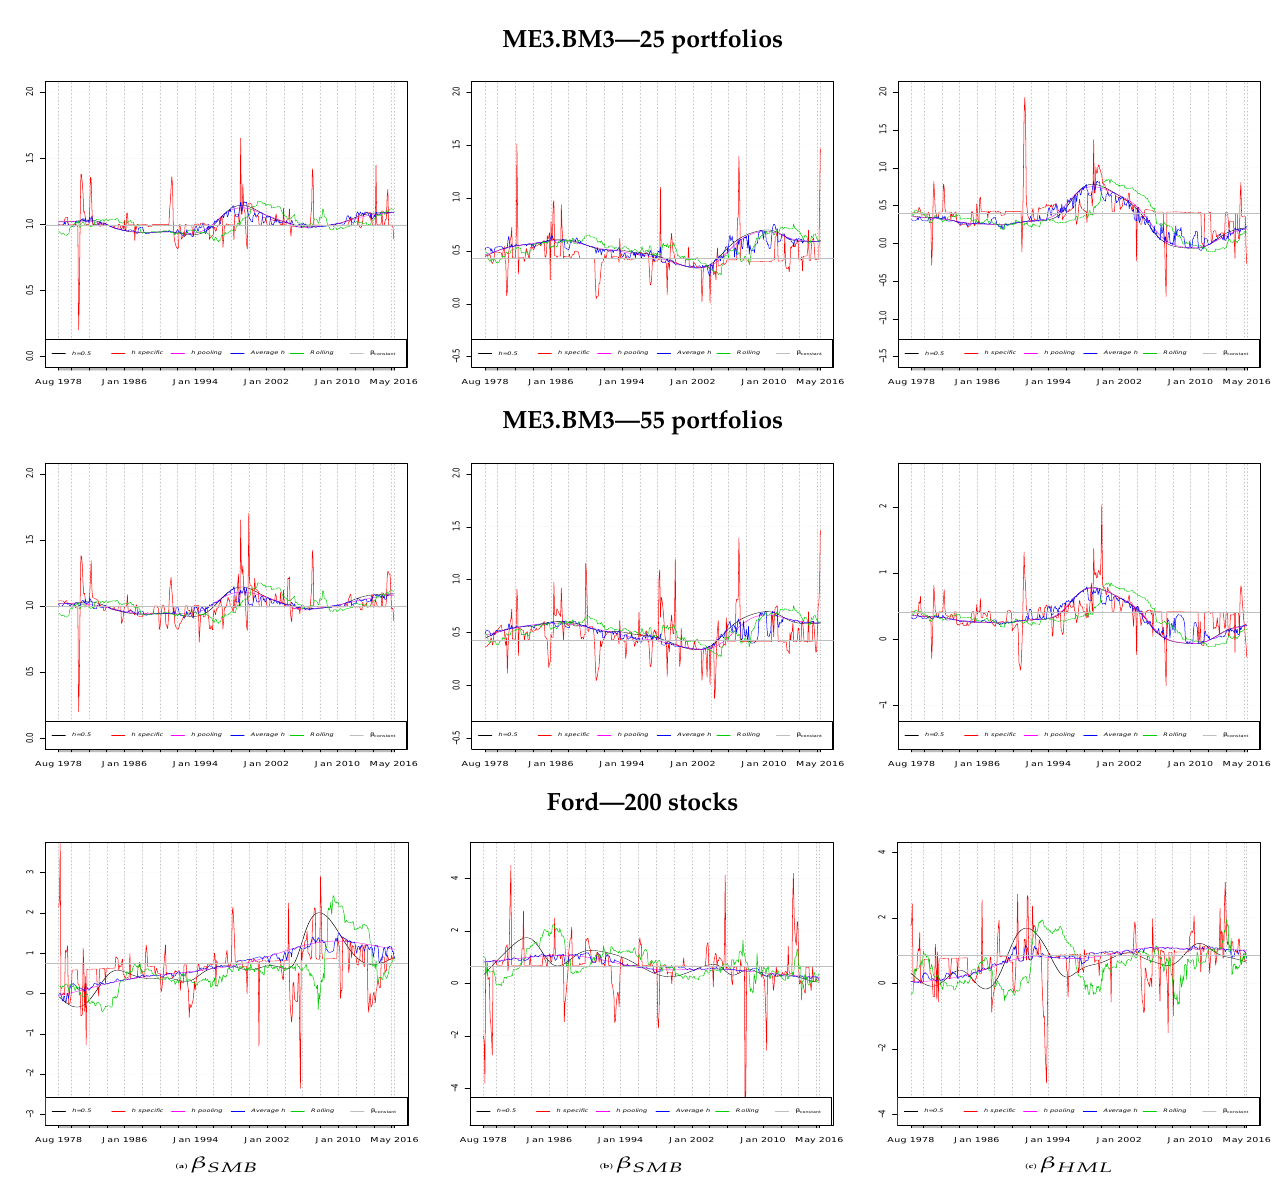
Figure 2. A dynamic comparison of the factor loading estimates. Note : The figure provides the estimates of factor risk loadings computed using the normal approach Constant β (grey line), Rolling window, with a 5-year estimation period (green line) and kernel-weighted regressions using 4 different optimal bandwidths; h = 0.5 (black line); Polling a single value of h coming from the poll average across assets and time, as shown in Equation (7), (purple line); Average , a unique time-varying bandwidth coming from the average of h across assets (Equation (8)), (blue line); Specific , multiple time-varying bandwidths, one for each asset and time (red line). The choice of the optimal bandwidth parameter h opt was made using the kernel approach, as discussed in Equation t